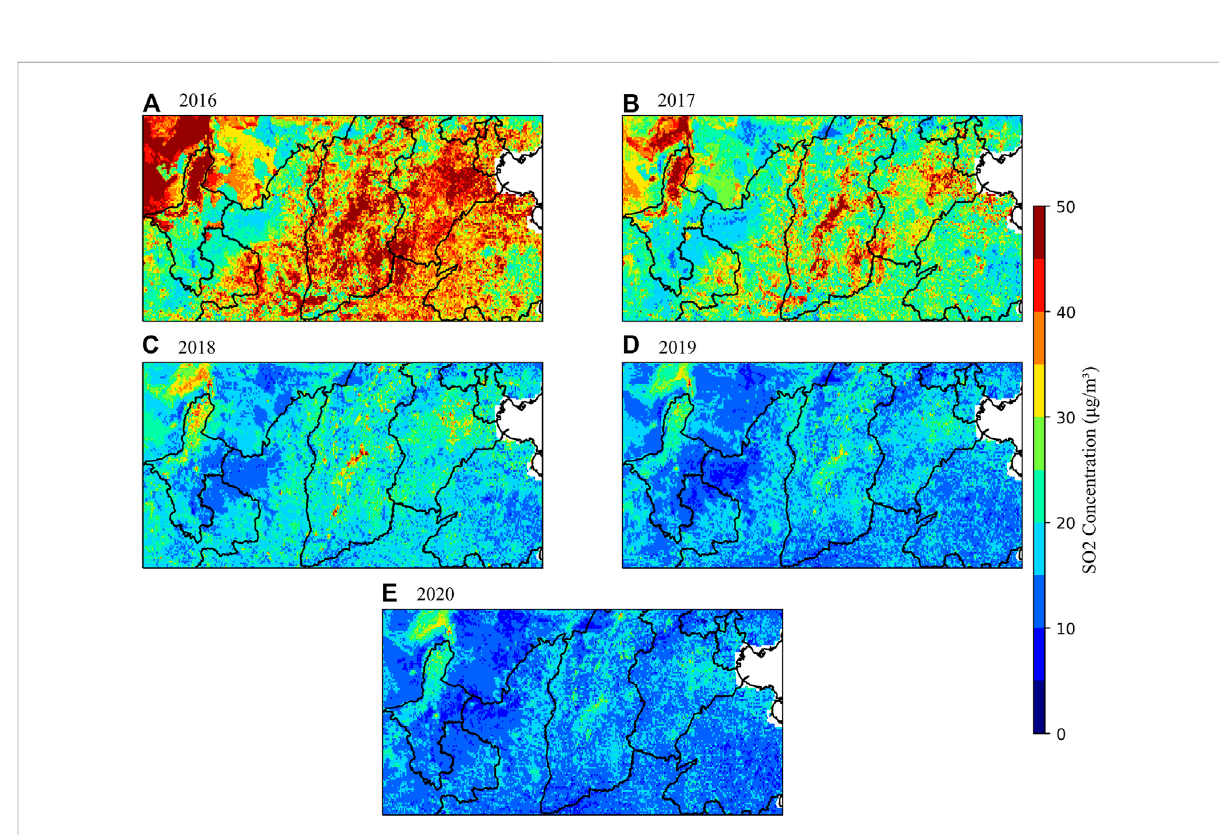
FIGURE 10 Spatial distribution of annual mean values of SO 2 in North China from 2016 to 2020 ( μ g/m 3 ).